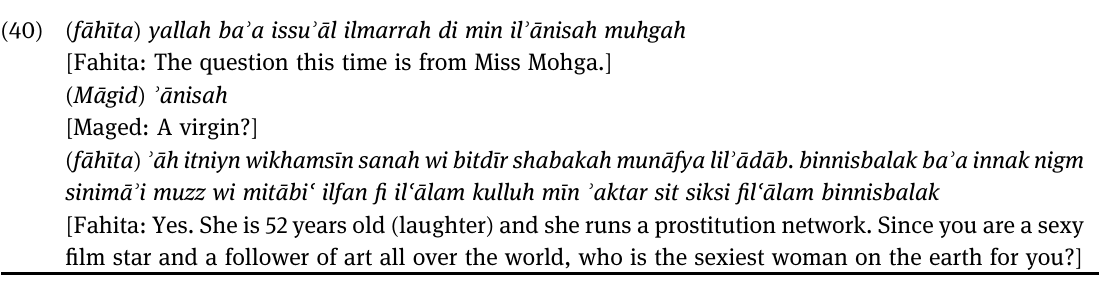
[ Fahita: Yes. She is 52 years old ( laughter ) and she runs a prostitution network. Since you are a sexy fi lm star and a follower of art all over the world, who is the sexiest woman on the earth for you? ] The description of the next fan, in Example ( 41 ) , as a 27 - year - old woman who has been convicted in a legal case for religious contempt is incongruous with the content of the question which has a religious aspect. It is known that Islam allows polygamy, giving men the licence to marry four wives. It is ironic, of course, that the fan would express contempt for religion except for this aspect. There is also an unpalatable presupposition in the question itself that Maged cheats on his wife. Maged ’ s sexual appeal is highlighted with the reference to him as ilmuzz [ the sexy guy ] . The use of the words ilmuzz to refer to a sexy guy and ilmuzzah to refer to a sexy woman is currently quite common in Colloquial Egyptian.